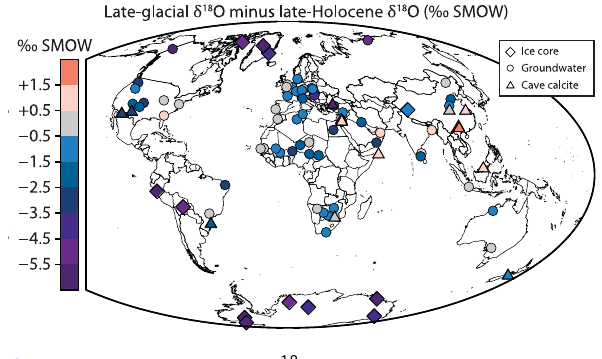
Figure 2. Meteoric water δ 18 O change from the late-glacial (20000 to ∼ 50000 years ago) to the late-Holocene (within past ∼ 5000 years; average (cid:49) 18 O late-glacial values shown, where (cid:49) 18 O late-glacial = δ 18 O late-glacial − δ 18 O late-Holocene ). The low temporal resolution of groundwater records means that δ 18 O variations within each time period are smoothed and likely repre- sent unequal temporal weighting. References for measured mete- oric water δ 18 O changes for ice cores, groundwater and cave calcite are presented in the Supplement.